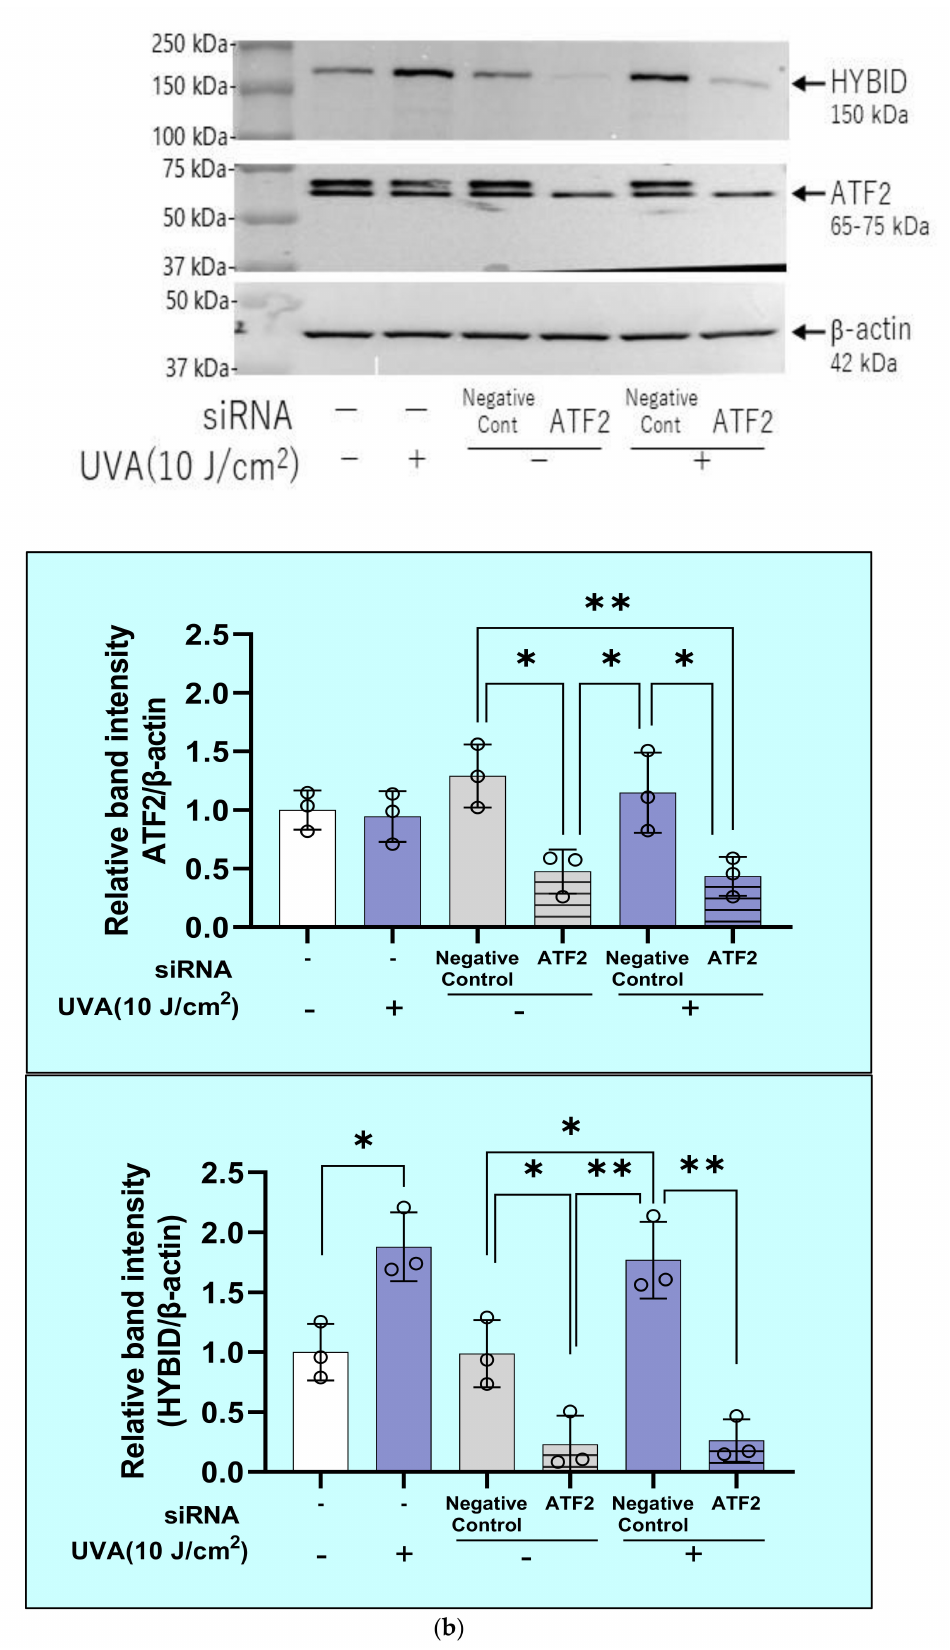
Figure 15. Effects of transfection of c-Fos ( a ) or ATF-2 ( b ) siRNA on the UVA-induced increase in the HYBID protein level in HDFs. ( a ) Effect of transfecting a c-Fos siRNA on the expression of c-Fos and HYBID proteins. ( b ) Effect of transfecting